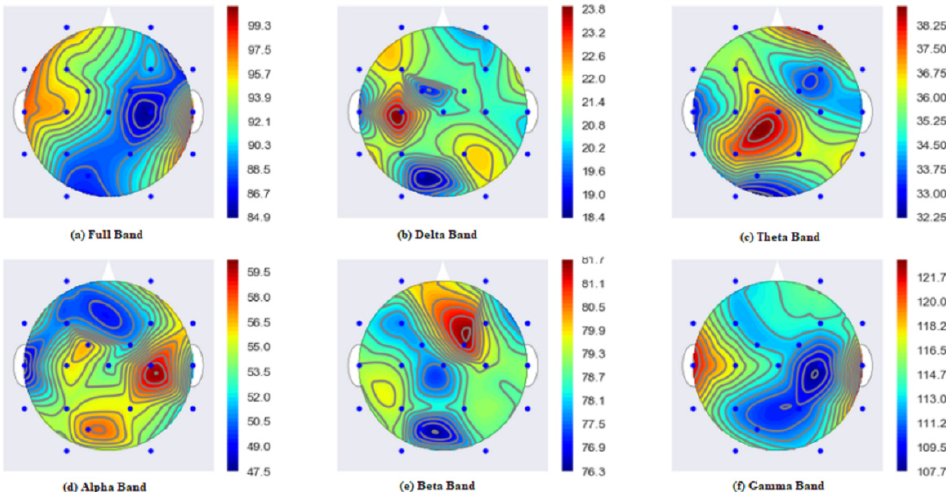
Figure 5. MCSV extracted frequency representation for the estimation of seizure behavior in the scalp, where ( a ) represents the full band; ( b ) gives the delta band activity; ( c ) is the theta band information; ( d ) represents the alpha band signals; ( e ) is the activity in the beta band; and ( f ) represents the activity in the frequency gamma band.